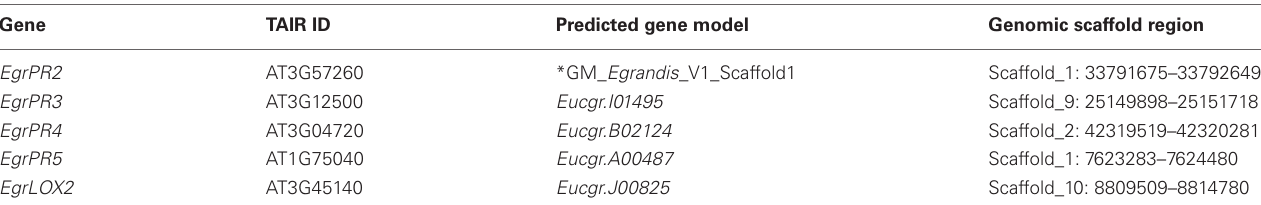
Table 2 | Predicted gene models and corresponding genomic scaffold regions selected as putative orthologs for the SA and MeJA defence signature genes in E. grandis.